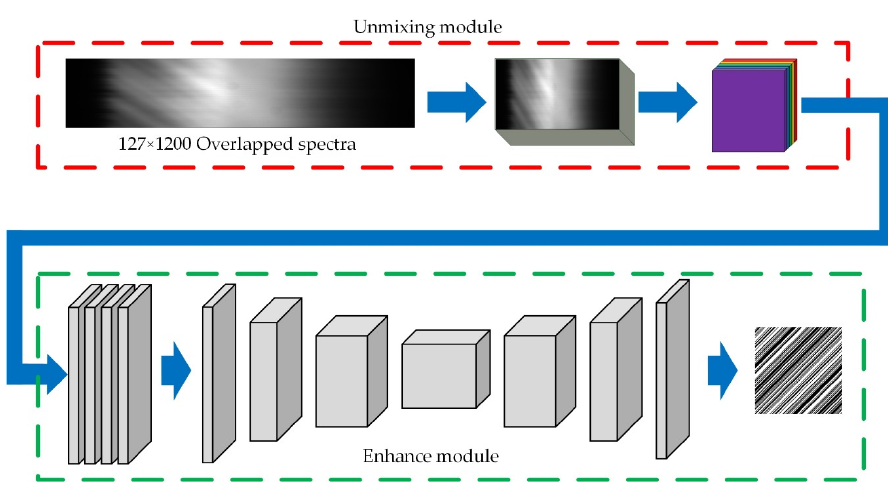
Figure 3. Structural sketch of the network model.